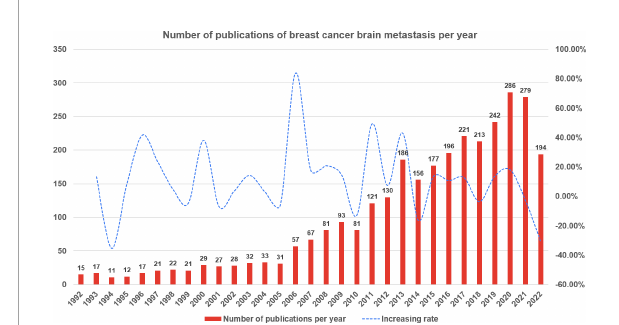
FIGURE 2 The annual number of publications of breast cancer brain metastasis from 1 January 1992 to 7 October